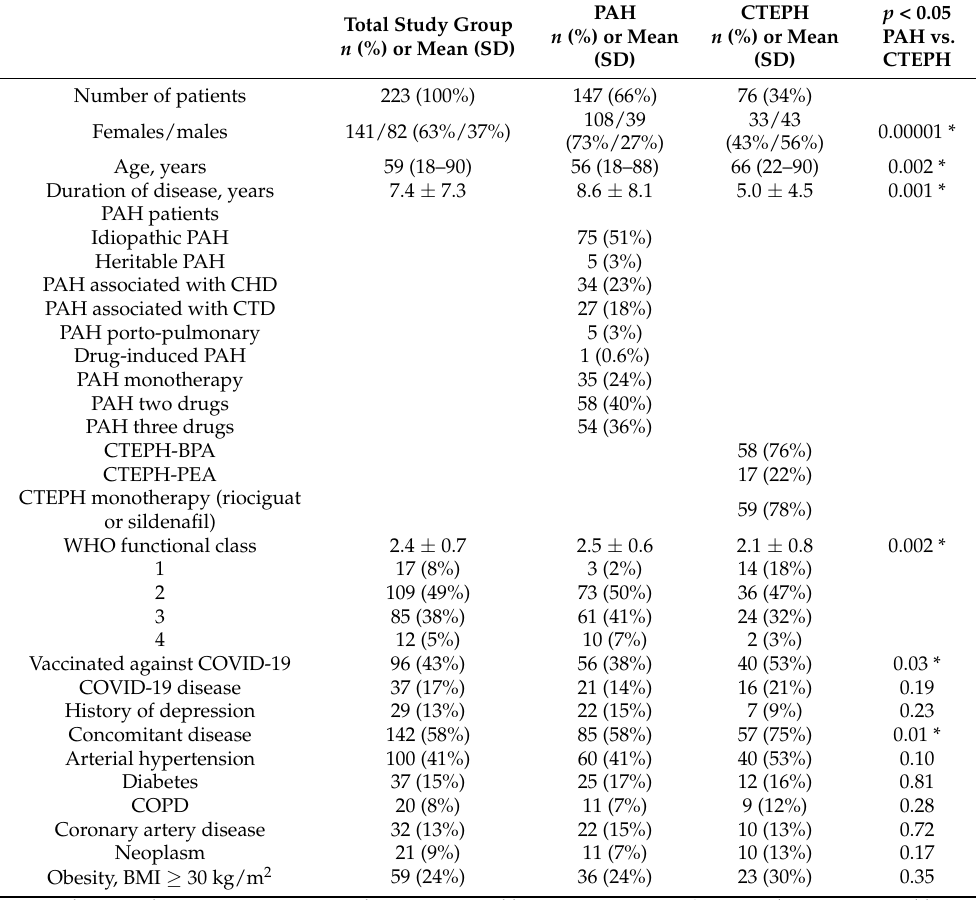
Table 1. Characteristics of the study group patients according to the pulmonary hypertension